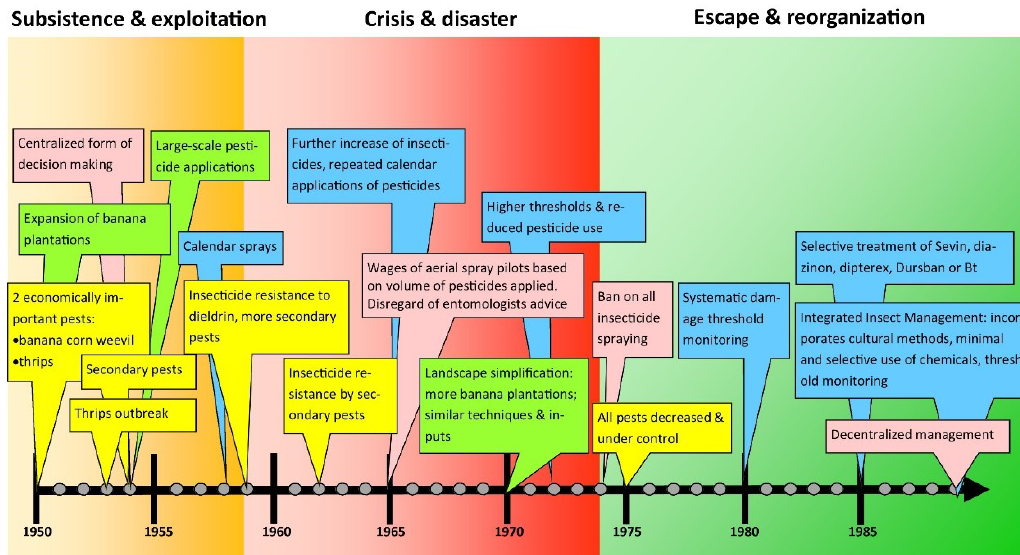
Figure A1.2: Timeline representing enabling and disabling drivers (text balloons) of pesticide use in banana production in the Golfito zone, Costa Rica from 1950-1990. Colours referring to domains in the framework: farming (yellow), agro-landscapes ( green), science & technology (blue), and society (pink). The colours in the background (orange-red-green) indicate the transition to a new phase of the